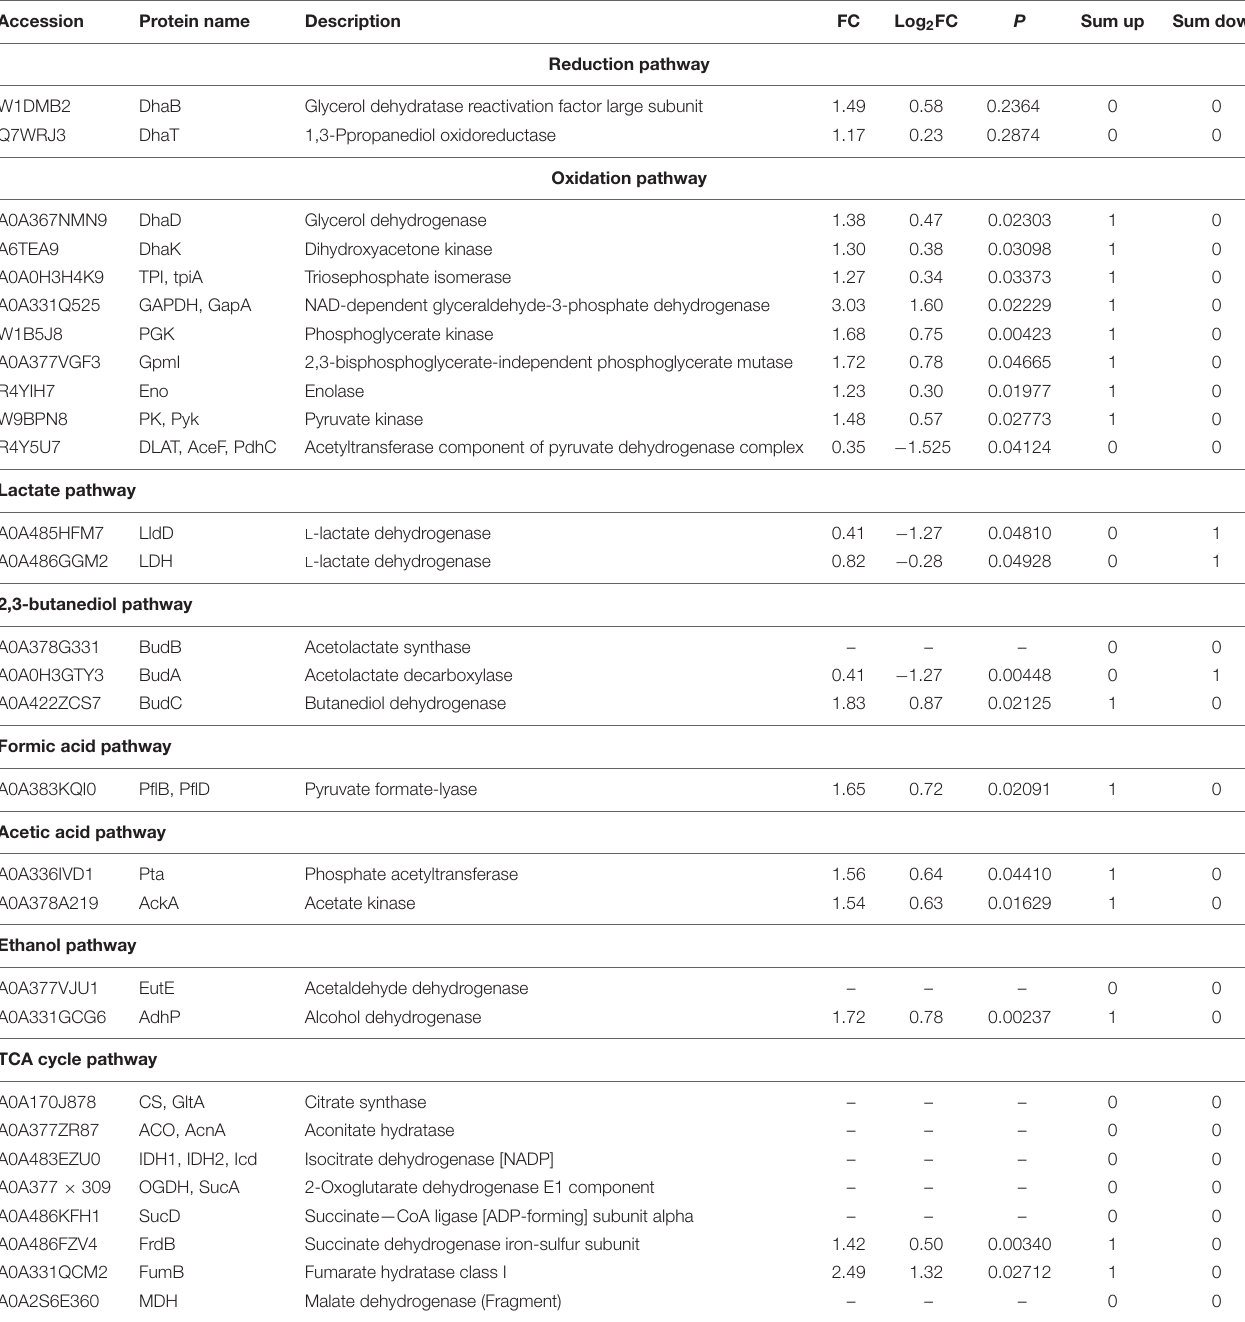
TABLE 2 | The protein of the metabolic pathway for K. pneumoniae producing 1,3-PDO.